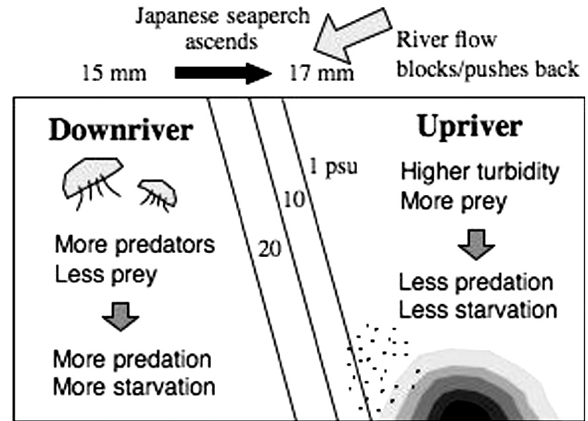
dots indicate aggregation of Sinocalanus sinensis , the major prey organism of Japanese seaperch, and grey areas the estuarine turbidity maximum